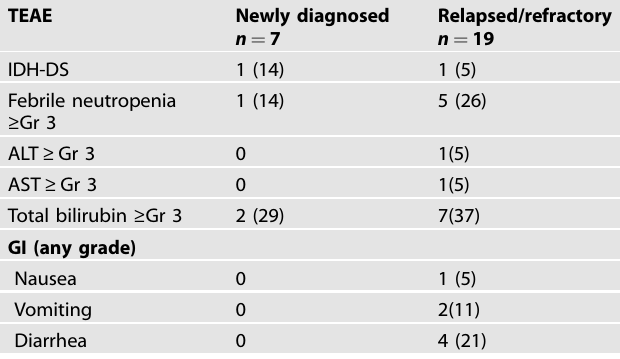
Table 3. Treatment emergent adverse events in newly diagnosed and relapsed/refractory patients with IDH2 mutant acute myeloid leukemia.